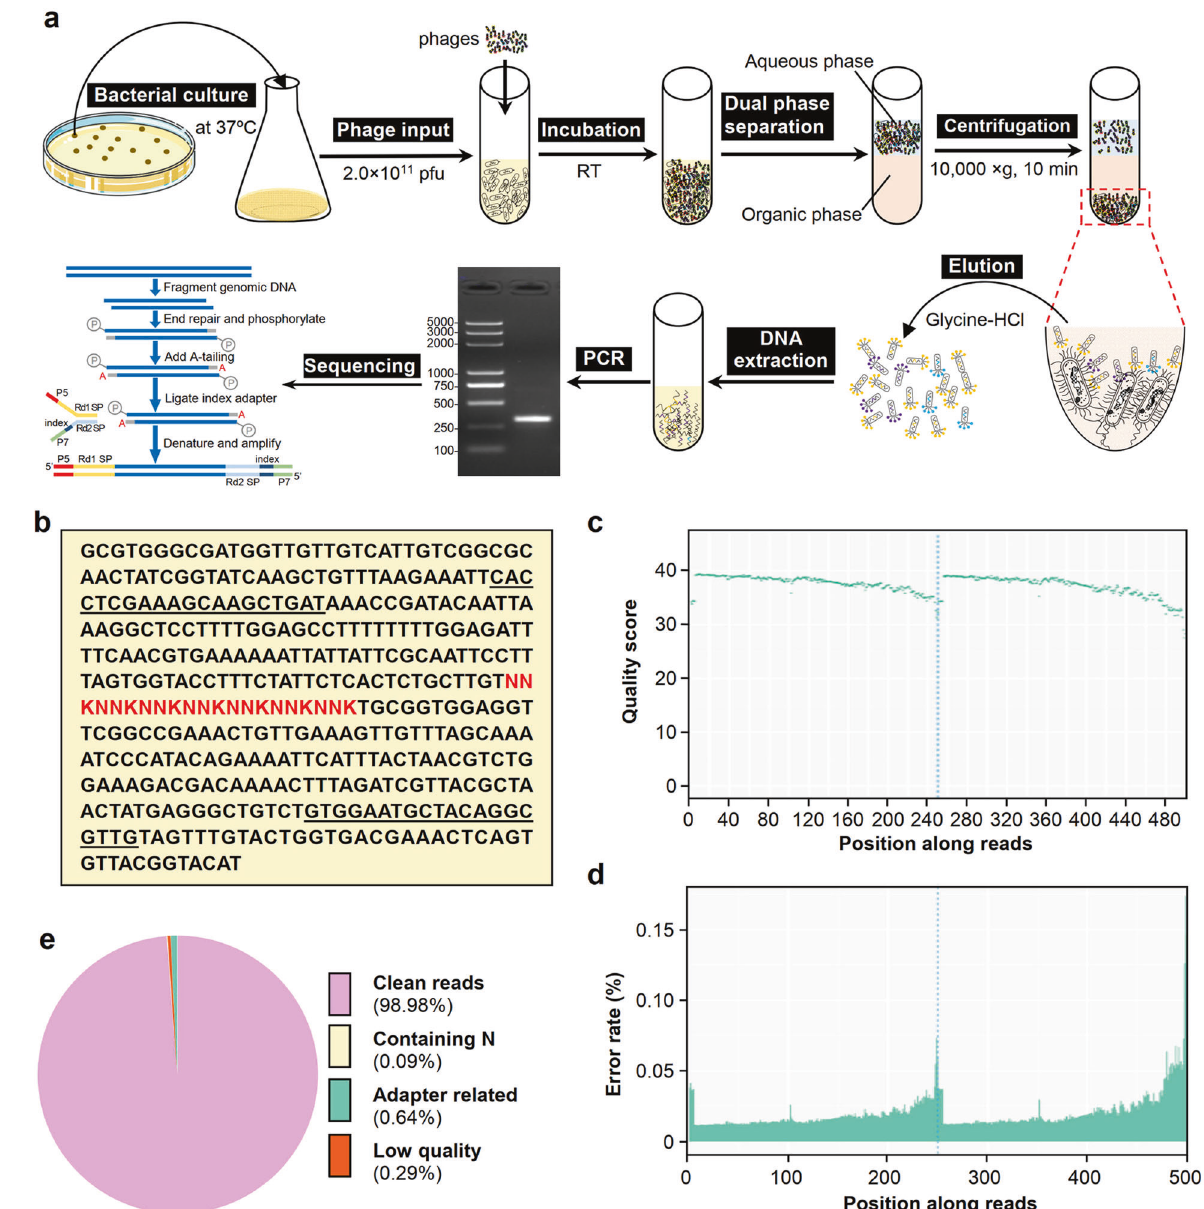
Fig. 2 Biopanning and sequencing of phages speci fi cally binding to pathogenic bacteria. a Flowchart for biopanning of heptapeptides (C7Cs) that bind to pathogenic bacteria from a phage display random peptide library. After being cultured at 37 °C to an OD 600 of approximately 1.0, the bacteria were collected and incubated with 2 × 10 11 pfu phages in a fi nal volume of 250 μ L at room temperature for 10 min. The mixture was separated by the modi fi ed Biopanning and Rapid Analysis of Selective Interactive Ligands (BRASIL) method. After centrifugation at 10,000 × g for 10 min, the precipitated phages bound to bacteria were washed 3 times with PBS. The phages were eluted with glycine-HCl, followed by DNA extraction and PCR ampli fi cation. The PCR products containing the sequences encoding heptapeptides were resolved by electrophoresis on 2% agarose and collected for HTS. b The DNA sequence encoding random C7C peptides and protein III fusion protein (C7C-PIII). The NNK sequence (red) represents the DNA sequences for random heptapeptides fused to the sequence of phage gene III. The primers designed as the underlined sequences were used to amplify the DNA encoding heptapeptides. Here, N represents any nucleobase, G, C, A or T, while K represents G or T. c Quality score distribution along reads of PCR products of DNA encoding heptapeptides. The PCR products were sequenced by using a MiSeq instrument (Illumina) with a 250-bp paired-end-read format. d Error rate distribution along reads. The PCR products were sequenced as described in ( c ). e The composition of the raw data from HTS. The reads, including clean reads, reads containing N, adapter-related reads and low-quality sequences, were analyzed for the quality control of sequencing between log-transformed frequency and the fl uorescence inten- intensity of His-EGFP-C7C was analyzed, and we found that the sity of His-EGFP-C7C (Fig. 5g). log-transformed heptapeptide frequency without normalization and the fl uorescence intensity of His-EGFP-C7C failed to show any Antimicrobial activity of the C7C-LL37 in vitro signi fi cant correlation ( R ² = 0.02, P > 0.05) (Fig. 5f). Intriguingly, Several high-af fi nity heptapeptides, including VTKLGSL (VTK), normalization of heptapeptide frequency against the library KYYQTTQ (KYY), ISSSINH (ISS) and INSDPTR (INS), were used to brought about a signi fi cant correlation ( R ² = 0.77, P < 0.01) Signal Transduction and Targeted Therapy (2022)